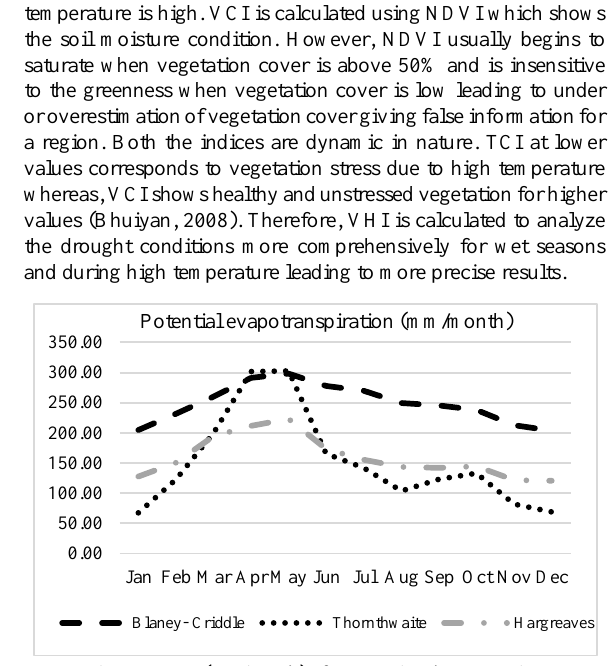
Figure 4: PET (mm/month) of Latur using three equations